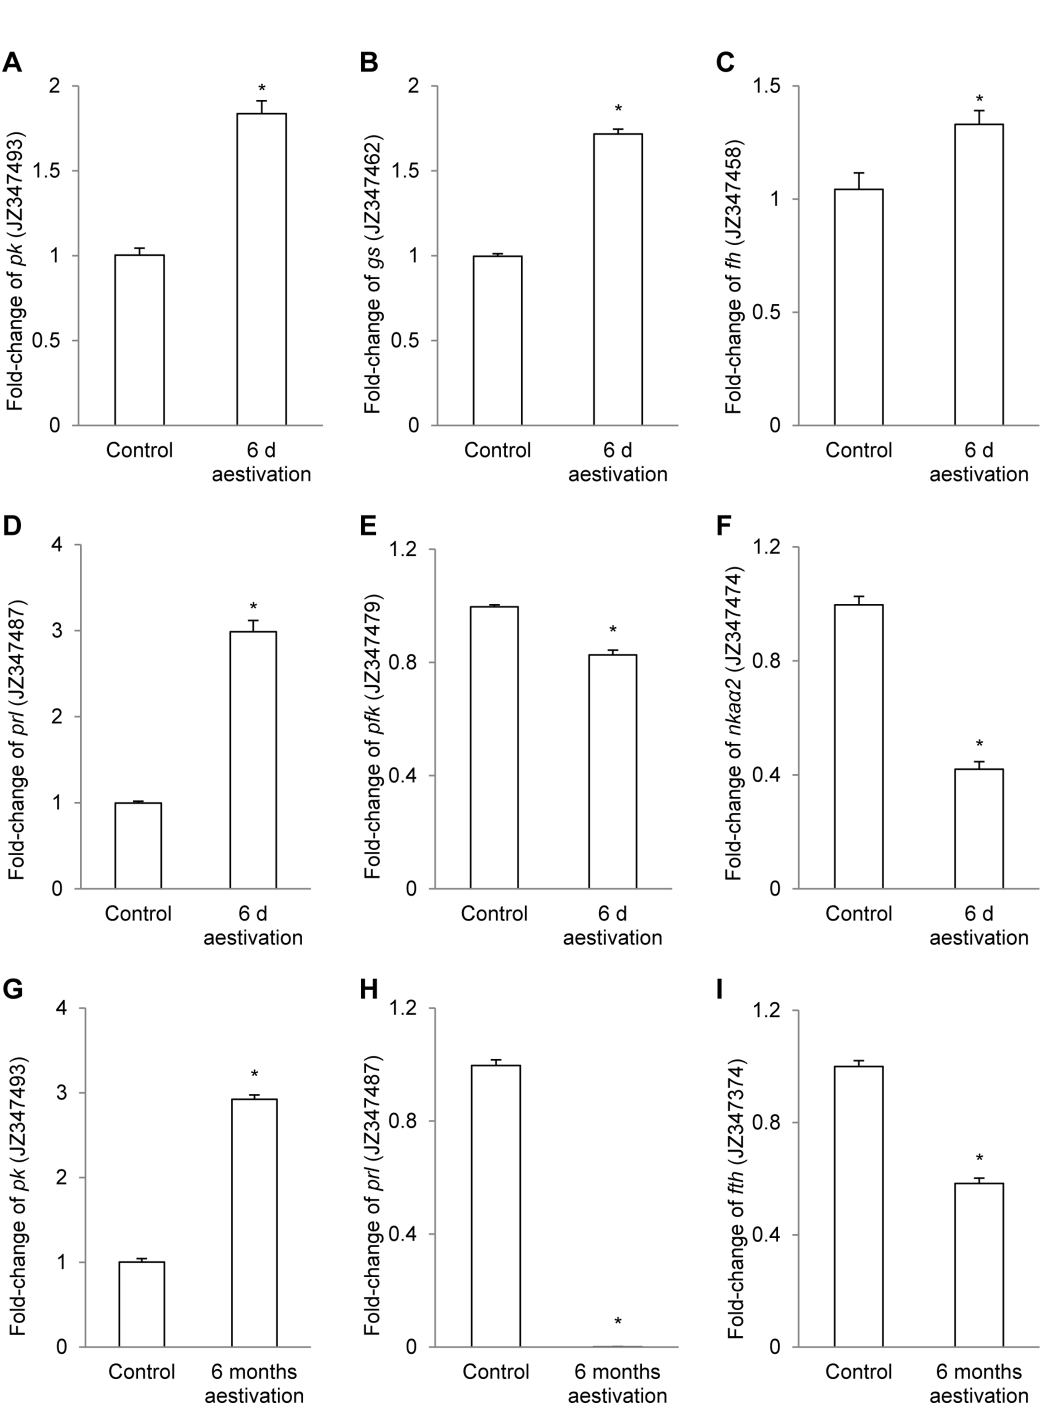
Figure 1. qRT-PCR of selected genes that were differentially expressed based on suppression subtractive hybridization. Relative quantification of mRNA expression (fold change) of (A) pyruvate kinase ( pk , JZ347493), (B) glutamine synthetase ( gs , JZ347462), (C) fumarate hydratase ( fh , JZ347458), (D) prolactin ( prl , JZ347487), (E) phosphofructokinase ( pfk , JZ347479), (F) Na + /K + -ATPase a 2 ( nka a 2 , JZ347474), (G) pyruvate kinase ( pk , JZ347493), (H) prolactin ( prl , JZ347487) and (I) ferritin heavy chain ( fth , JZ347374), using b -actin as the reference gene, in the brain of Protopterus annectens aestivated for 6 days (d) (A–F) or 6 months (G–I) in air with reference to the those of fish kept in freshwater as control. Results represent mean + S.E.M. ( N =6). *Significantly different from the corresponding freshwater control ( P , 0.05).